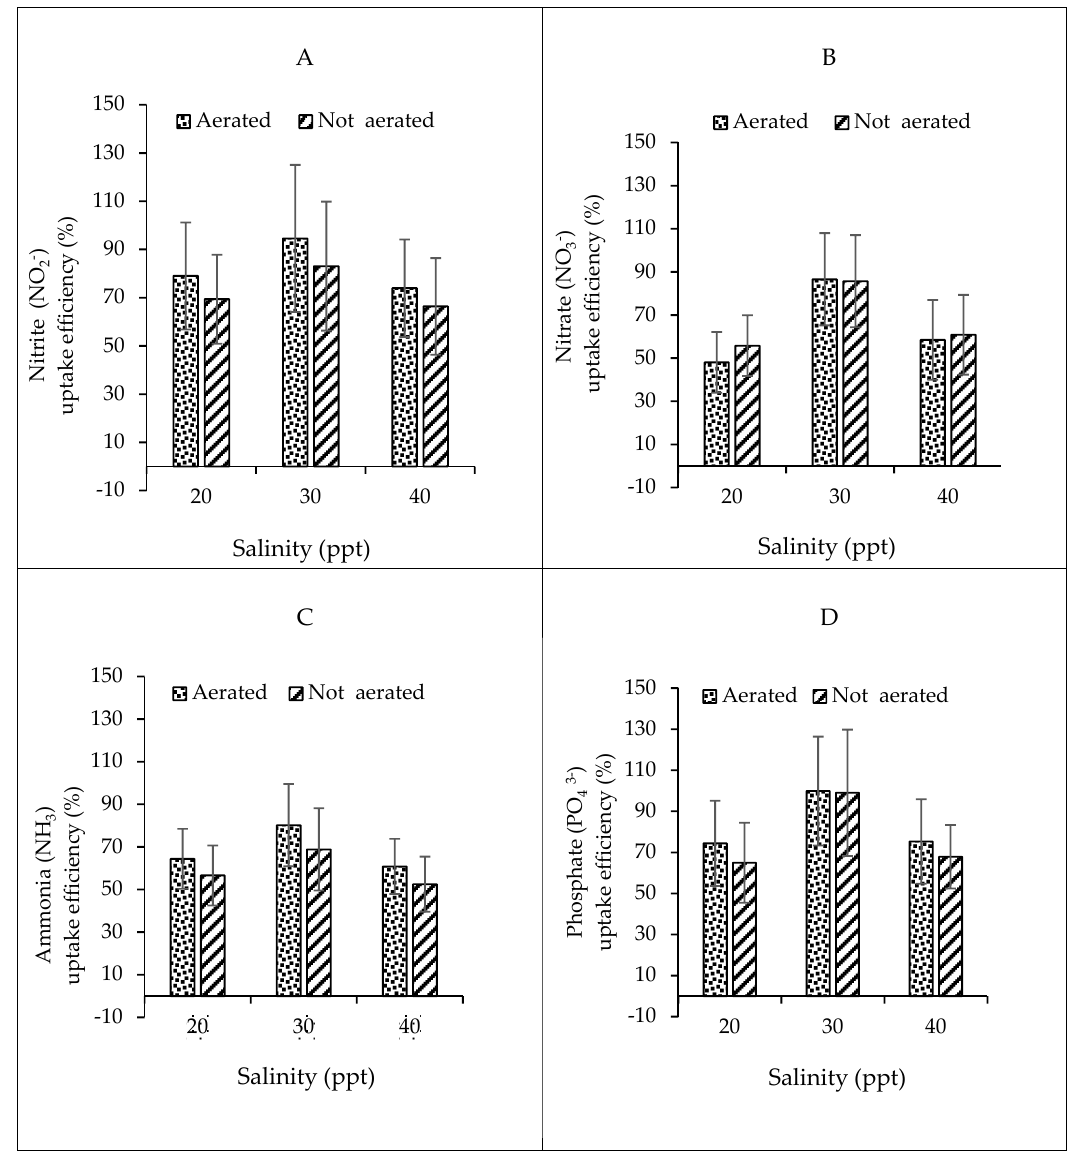
Figure 4. NUE of nitrite (NO 2 − ) ( A ), nitrate (NO 3 − ) ( B ), ammonia (NH 3 ) ( C ), and phosphate (PO 43 − ) ( D ) at three salinity levels with and without aeration with 30 g / L Caulerpa lentillifera density. The error bars indicate standard deviations. n = 3. Table 3. Tukey’s HSD results across three different salinity levels.